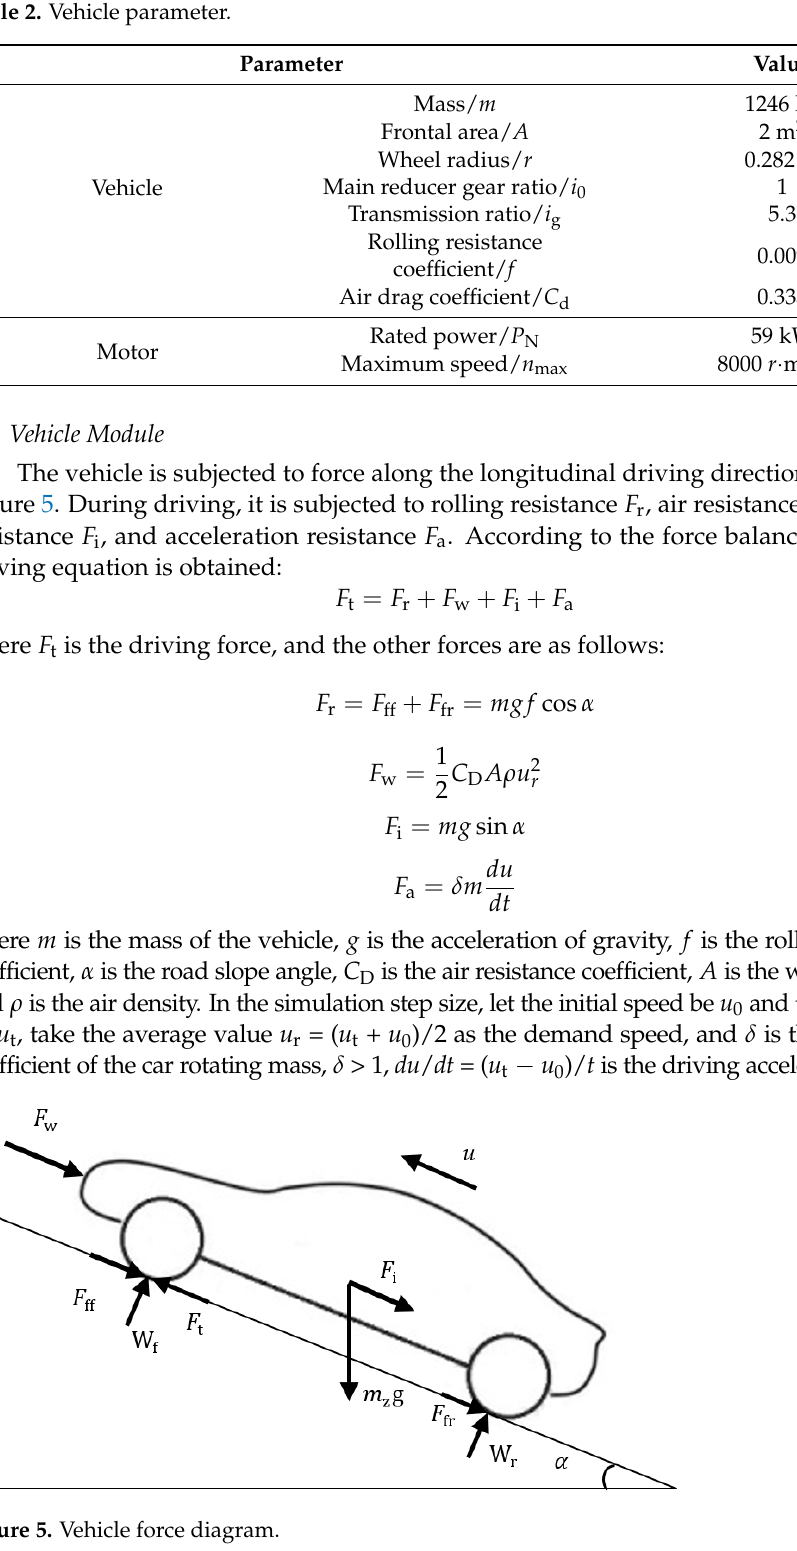
Figure 5. Vehicle force diagram.